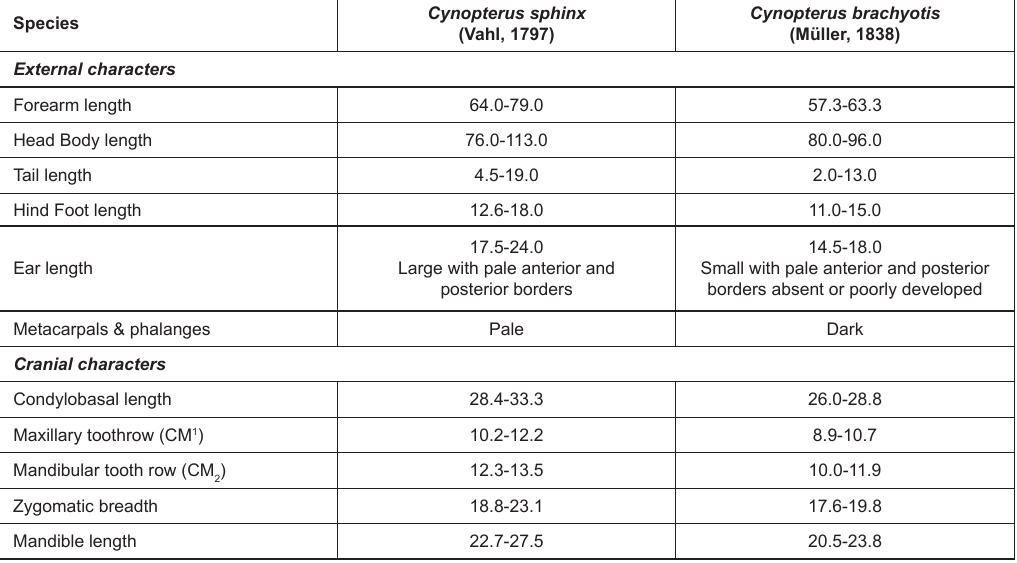
Table 3.3. Diagnostic morphological characters of the two species of the genus Cynopterus Cuvier, F., 1824 present in South asia